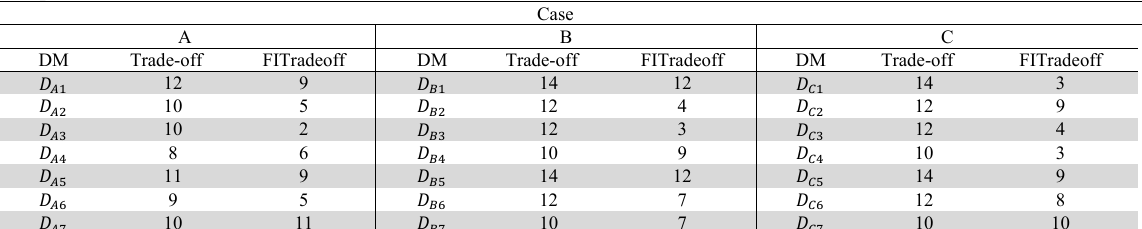
Comparison Trade-off results vs. FITradeoff for case